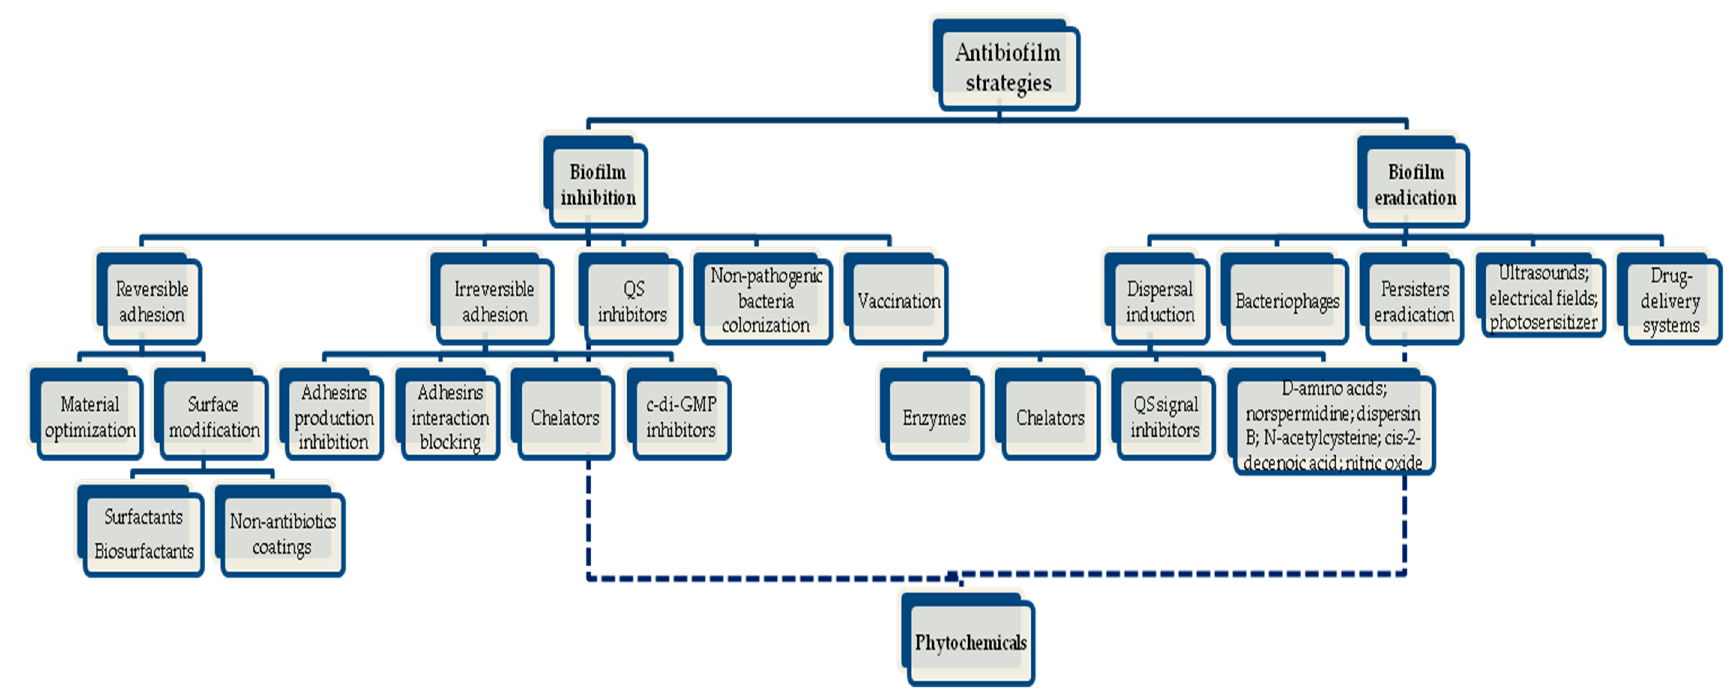
Figure 3. Main antibiofilm strategies. The suggested approaches can be divided in two major lines of action: some are meant to prevent biofilm formation and others to eradicate established biofilms, and they can comprise the application of physical, chemical and biological methods. Some of them such as QSI, chelating agents and the use of natural compounds from plants (phytochemicals) can be applied for both biofilm inhibition and eradication. Although the second messenger c-di-GMP is mainly involved in the transition of the planktonic to sessile state, it can be also used as a target to disperse biofilms. The use of photodynamic therapy and nanoparticles as drug carriers is not specific for biofilm removal, as they can be useful to inhibit biofilm formation.